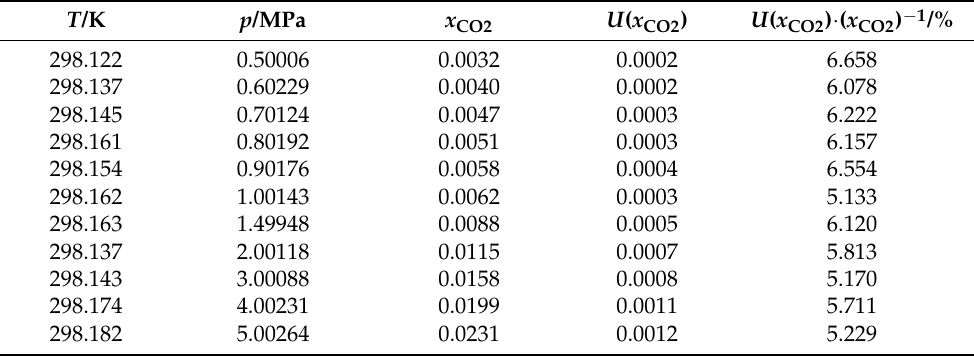
Table A3. Experimental results for solubility measurements of pure carbon dioxide in water at T = 298.15 K using Raman spectroscopy. Recorded temperature (ITS-90), pressure, mol fraction, and estimated uncertainties ( k = 2) are listed in the table.